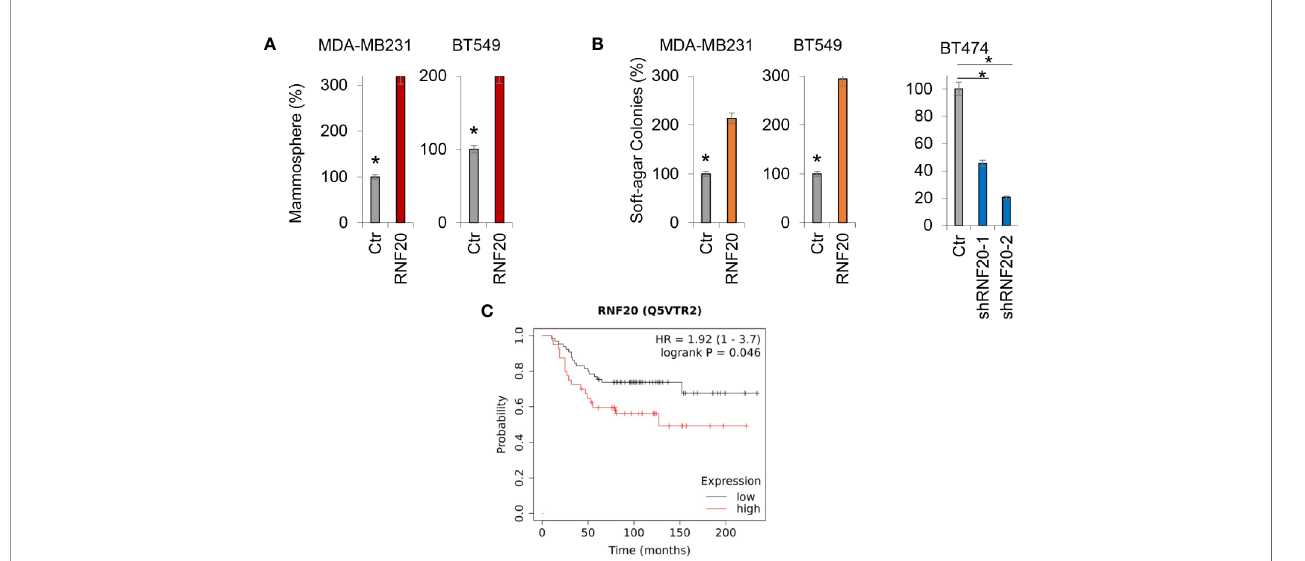
FIGURE 6 | RNF20 promotes tumorsphere and colony formation. (A) Tumorsphere formation of MDA-MB231 and BT549 cells with stable empty vector (Ctr) or overexpression of RNF20 was measured. (B) The formation of colonies was measured from MDA-MB231 and BT549 cells with stable empty vector (Ctr) or overexpression of RNF20, as well as BT474 cells with stable empty vector (Ctr) or knockdown of RNF20 expression. Data are presented as a percentage of empty vector cells lines (mean ± SD in three separate experiments). *P < 0.01 by Student ’ s t test (C) Kaplan-Meier survival analysis for overall survival (OS) of patients in a breast cancer dataset according to RNF20 protein expression status. The p value was determined using the log-rank